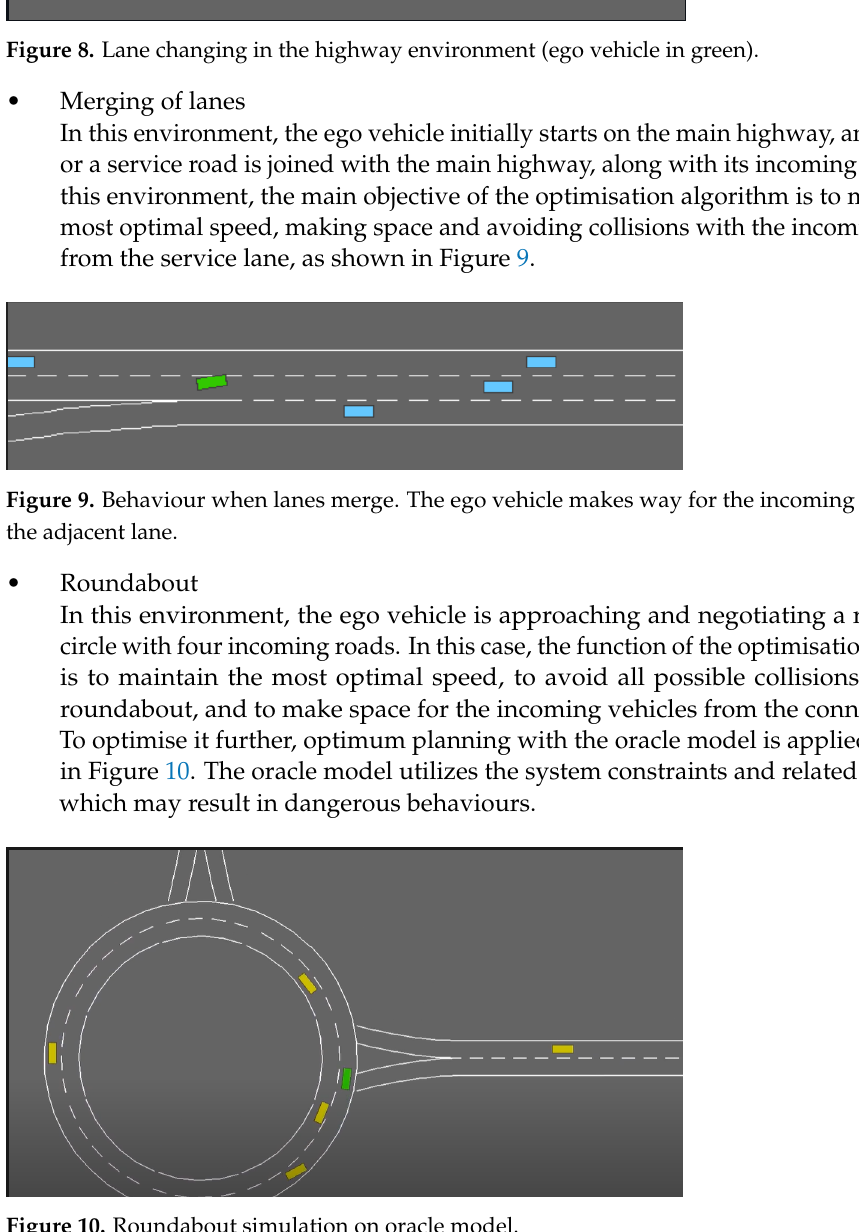
Figure 10. Roundabout simulation on oracle